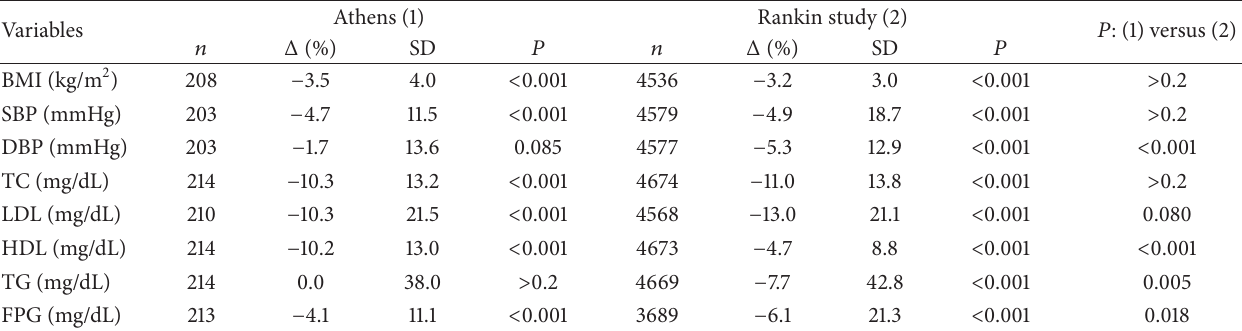
Table 2: Mean changes in selected risk factors in 225 participants of the Athens, OH, CHIP classes, compared to 5066 participants who participated in CHIP interventions in the US (Rankin et al.